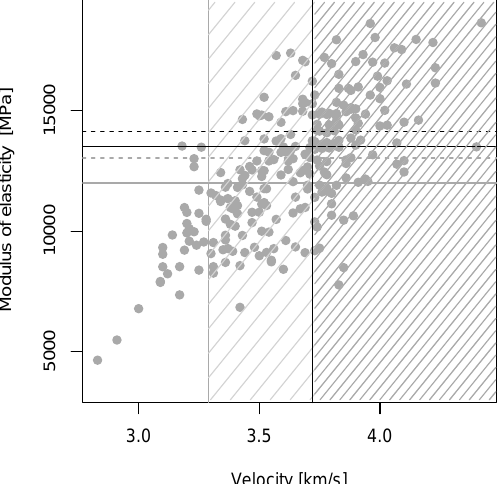
Figure 4. Scatterplot of static modulus of elasticity vs. velocity measured on wet timber and not adjusted for moisture content. Vertical lines = settings recalculated at 40% MC for D35 (grey) and D45 (black); solid horizontal lines = mean values of modulus for the classes D35 (grey) and D45 (black); dashed horizontal lines = mean values of modulus of pieces assigned to D35 (grey) and D45 (black); sparse oblique lines = pieces assigned to D35; dense oblique lines = pieces assigned to D45.